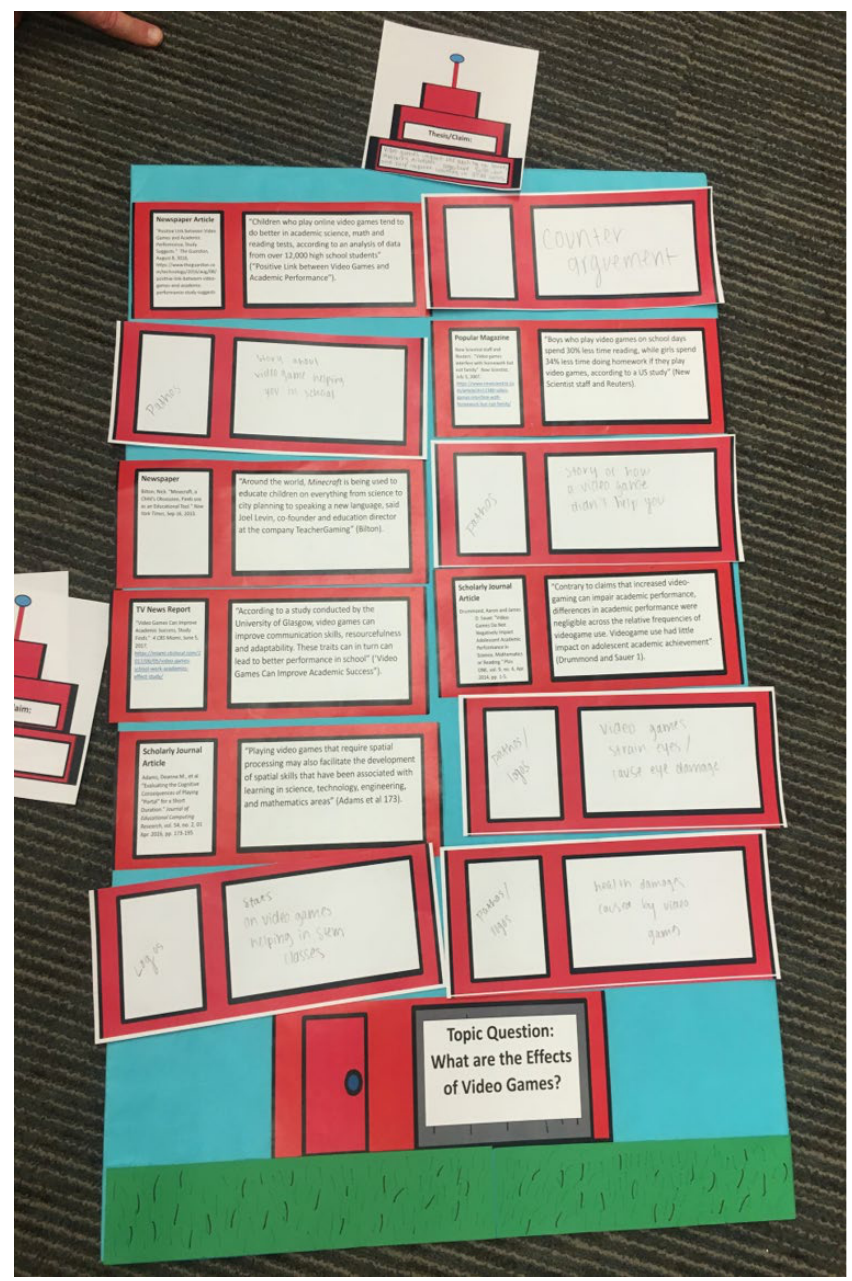
A “Wild Card” round’s tower, showing two opposing arguments, a student-written thesis, and the written-in sources students wanted to find to finish supporting each side. Note that students classified “wanted” sources in terms of classical rhetorical elements learned in their English 15 class - an element we had not prompted or previously considered